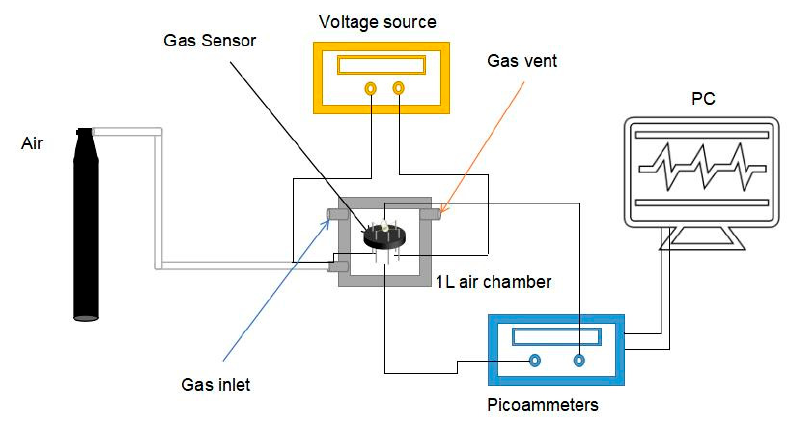
Figure 1. Gas testing unit.